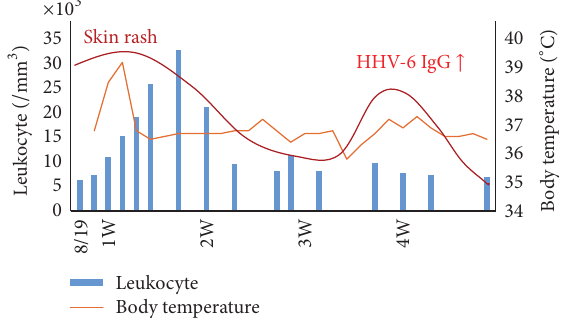
Figure 3: Clinical course of the